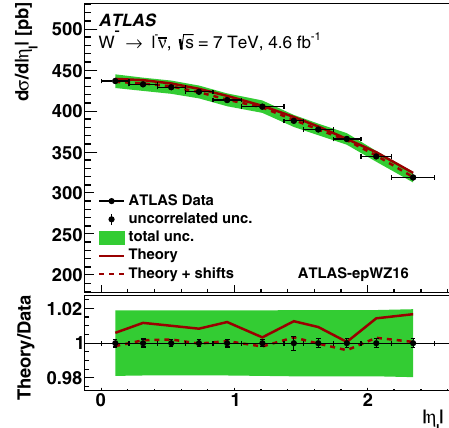
Fig. 28 Differential cross-section measurements for W + → (cid:3) + ν ( right ) and W − → (cid:3) − ¯ ν ( left ) compared to the predictions of the QCD fit. The predictions are shown before ( solid lines ) and after ( dashed